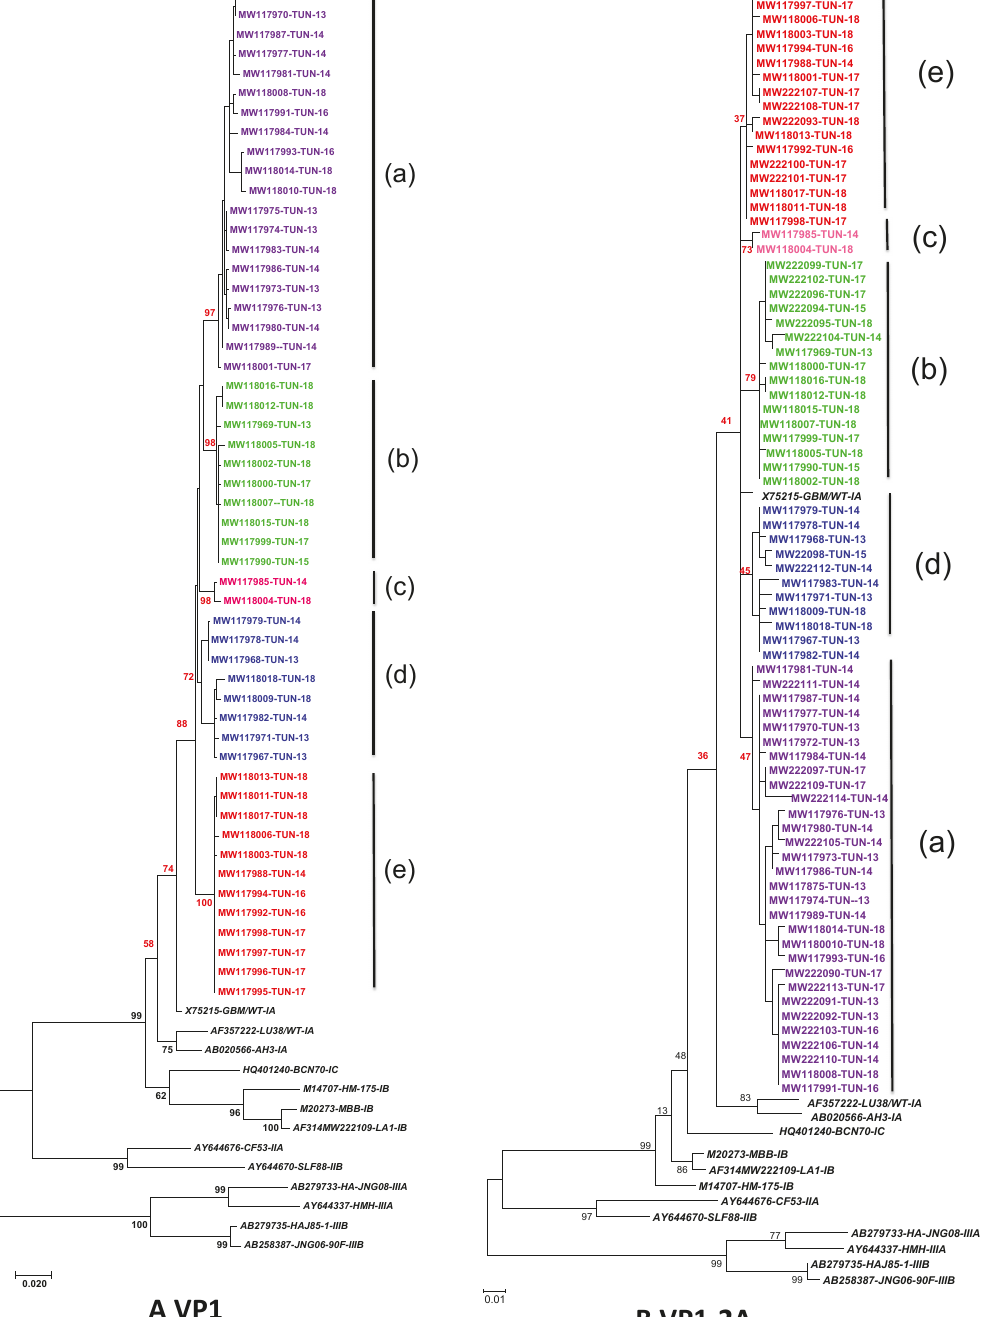
Figure 1. Phylogenetic trees comparing nucleotide sequences of HAV strains isolated in Tunisia during 2013–2018 with the reference sequences. The tree was performed using the maximum likelihood method and the kimura-2 parameter model. Topology was supported by 1000 bootstrap replicates. The sequences reported in this study were identified by the accession numbers. The sequences of isolates reported in this study are indicated by their accession number followed by the country code and the year of isolation. Reference HAV strains are shown in italic. Clusters are designed ( a – e ). The same color is assigned to the same sequences grouped in the same cluster. ( A ). Phylogenetic tree comparing 884nt of the VP1 region of 52 strains from this study with 12 reference HAV strains. ( B ). Phylogenetic tree comparing 319 nt of the VP1-2A region of 77 strains from this study with 12 reference HAV